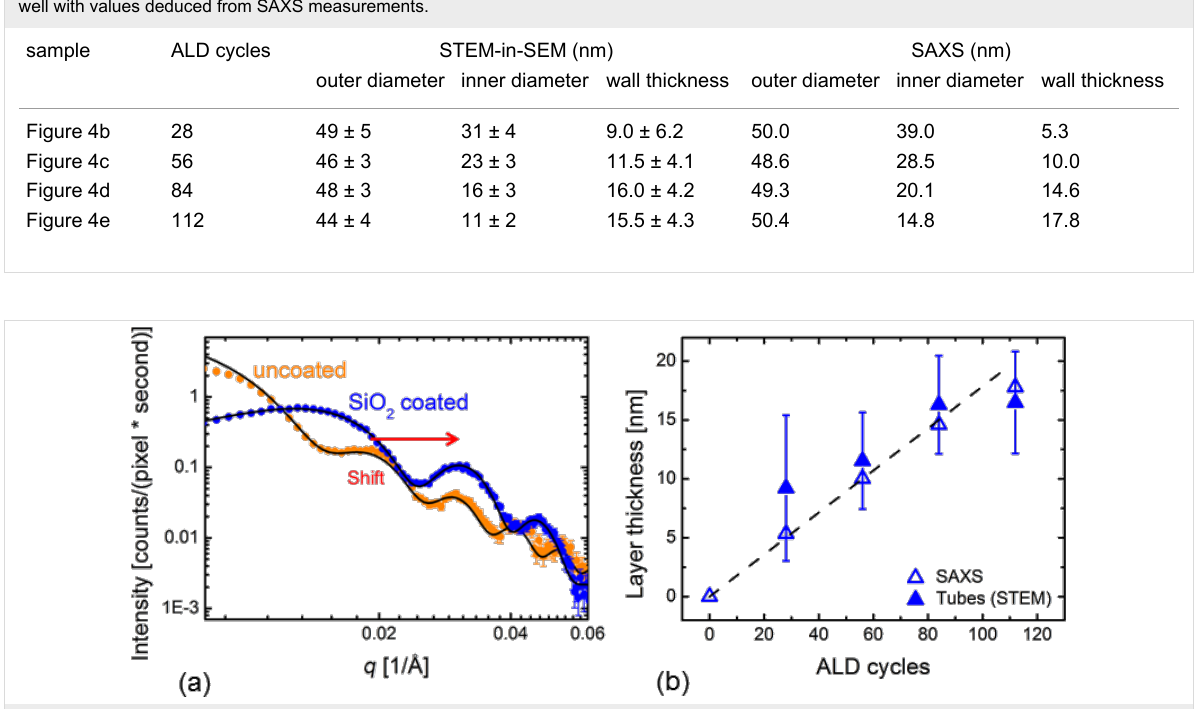
Figure 5: (a) Small angle X-ray scattering intensities as a function of the scattering vector q for an uncoated PC membrane (orange) and the same membrane coated with a 10 nm thick SiO 2 layer after 56 ALD cycles (blue). (b) SiO 2 layer thickness as a function of the number of ALD cycles according to analysis by SAXS (empty symbols) and STEM (solid symbols). The dashed line is a guide to the eye.